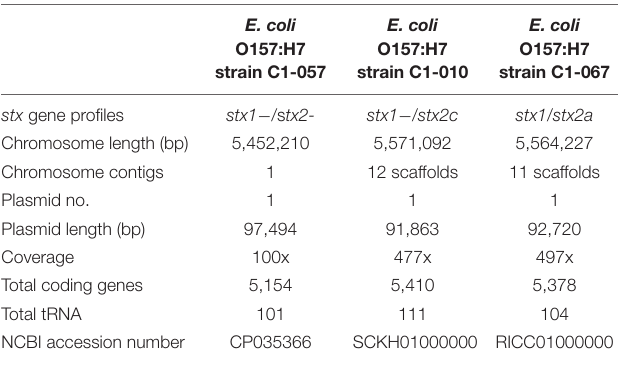
TABLE 2 | General genomic features of the three newly sequenced Escherichia coli O157:H7 strains with different stx